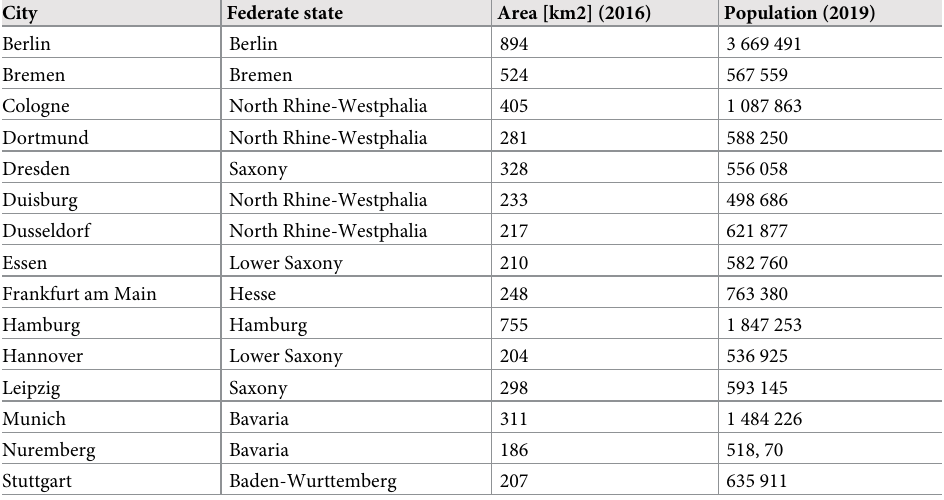
Table 2. Overview of sampled cities. Area and population figures as reported by the Federal Bureau of Statistics [35], with area figures rounded